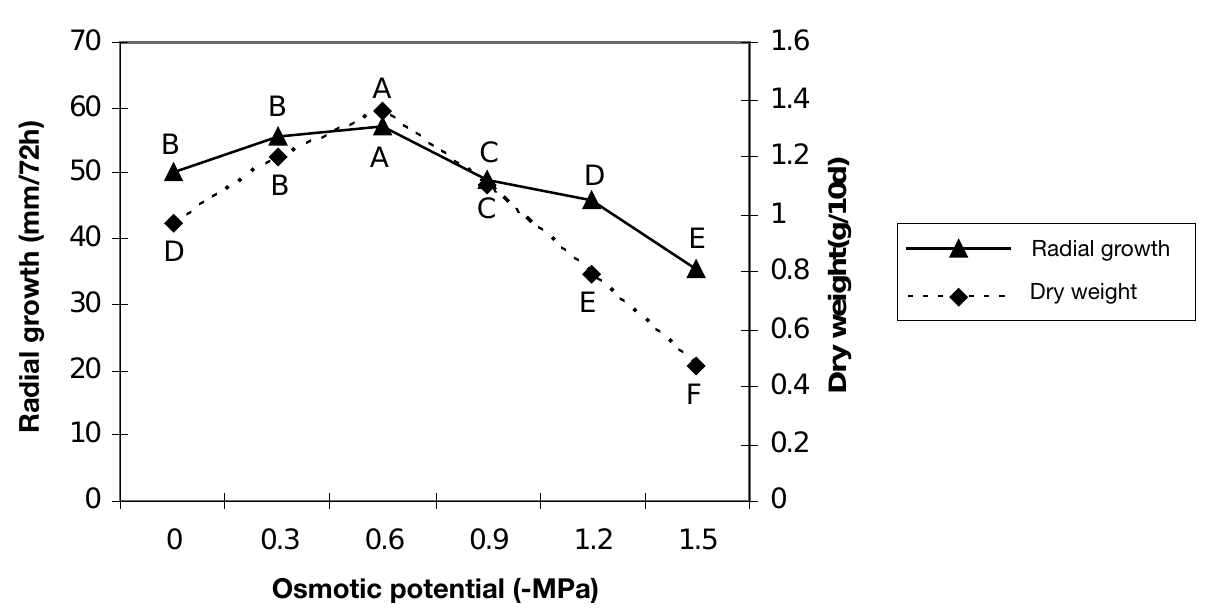
Fig. 2. Effect of osmotic potential on the radial growth and dry weight of Macrophomina phaseolina mycelia. Signi fi cant differences between treatments are indicated by different capital letters (Duncan, P ≤ 0.05).